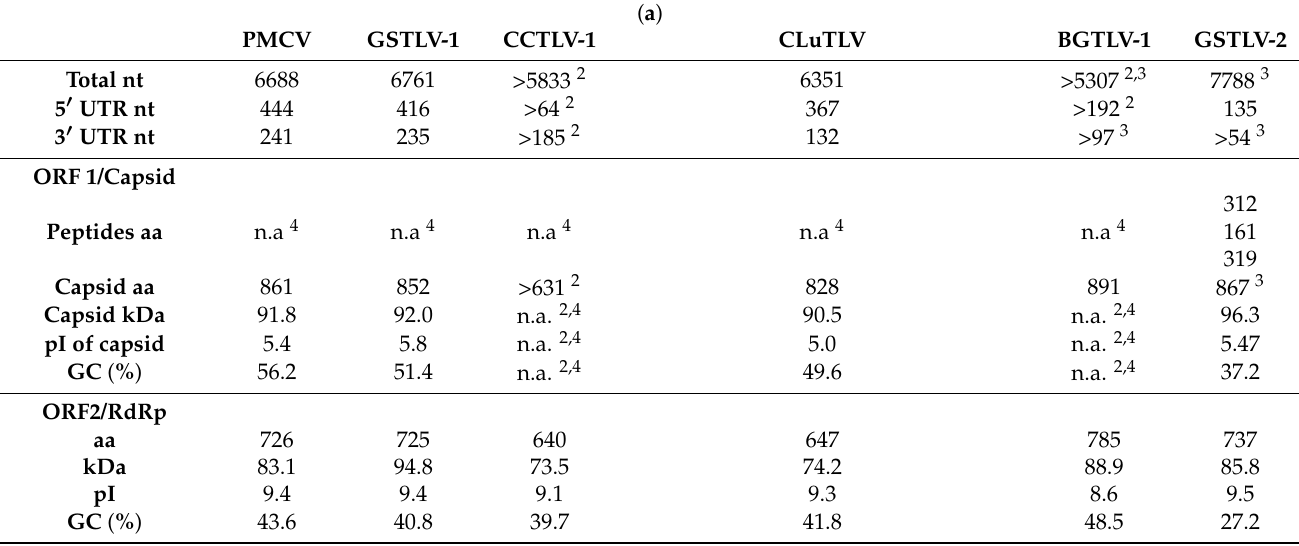
Figure 1. Schematic overview of genomes of piscine toti-like viruses including additional 3 (cid:48) end open reading frame(s) (ORF). Nucleotide (nt) numbering given as first nt of start codon and last nt of last translated codon. ORF2 is given including putative start codon(s) and resulting number of amino acids (aa) encoded, but for PMCV, GSTLV-1, and CCTLV-1, position for a characteristic slippery site which can result in translation of ORF1 and ORF2 as a fusion protein is also shown by dotted line with genomic position of site. A putative slippery site is also indicated similarly for CLuTLV. For GSTLV-1 an alternative start codon for ORF2 and ORF3 is indicated in grey lines. All sizes of boxes defining ORFs and lines defining untranslated regions (UTRs) are in correct ratio and each genome is centered around ORF2 in all to ease visual size comparison. Genomic information is expected to be incomplete in 5 (cid:48) end of CCTLV-1. Table 1. Comparison of features of UTR’s and encoded proteins of the six piscine toti-like viruses. Number of amino acids (aa), predicted mass (kDa) and isoeletrict point (pI) of proteins encoded by the ORFs and GC content of nucleotides in each ORF. ( a ) General characteristics and ( b ) characteristics of full capsid-RdRp fusion protein if predicted -1 ribosomal frameshift is in use and fused RdRp-part from frameshift site in ORF1 to stop codon in ORF2. ( a